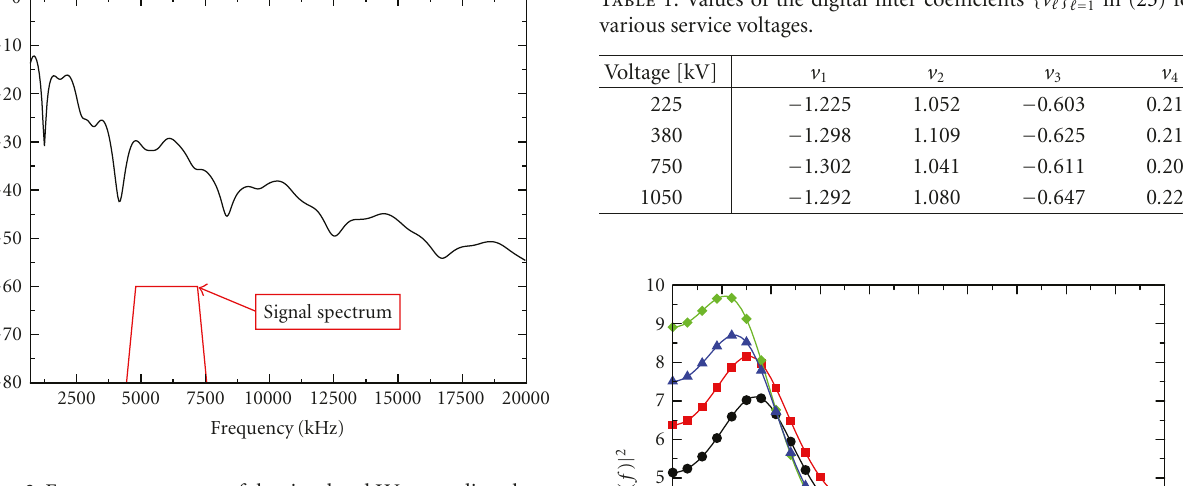
Figure 3: Frequency response of the simulated LV power line chan- nel and the transmission spectrum used by the considered single- carrier PLC system.